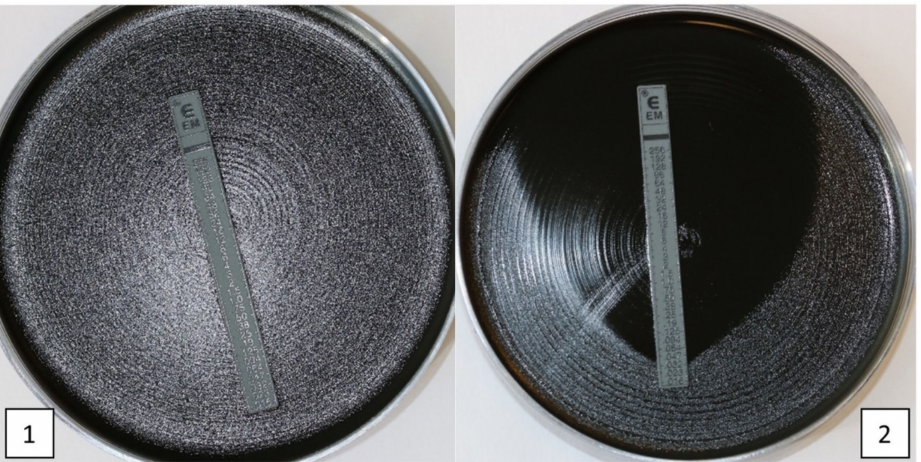
Figure 2. Etest of B. pertussis on Regan–Lowe charcoal agar with inoculation density equivalent of 0.5 McFarland standard. ( 1 ) = erythromycin resistant B. pertussis and ( 2 ) = erythromycin sensitive B. pertussis .